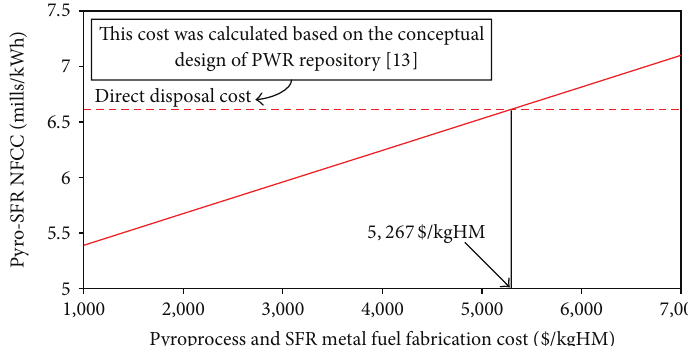
Figure 7: The break-even point of the manufacturing cost of SFR metallic nuclear